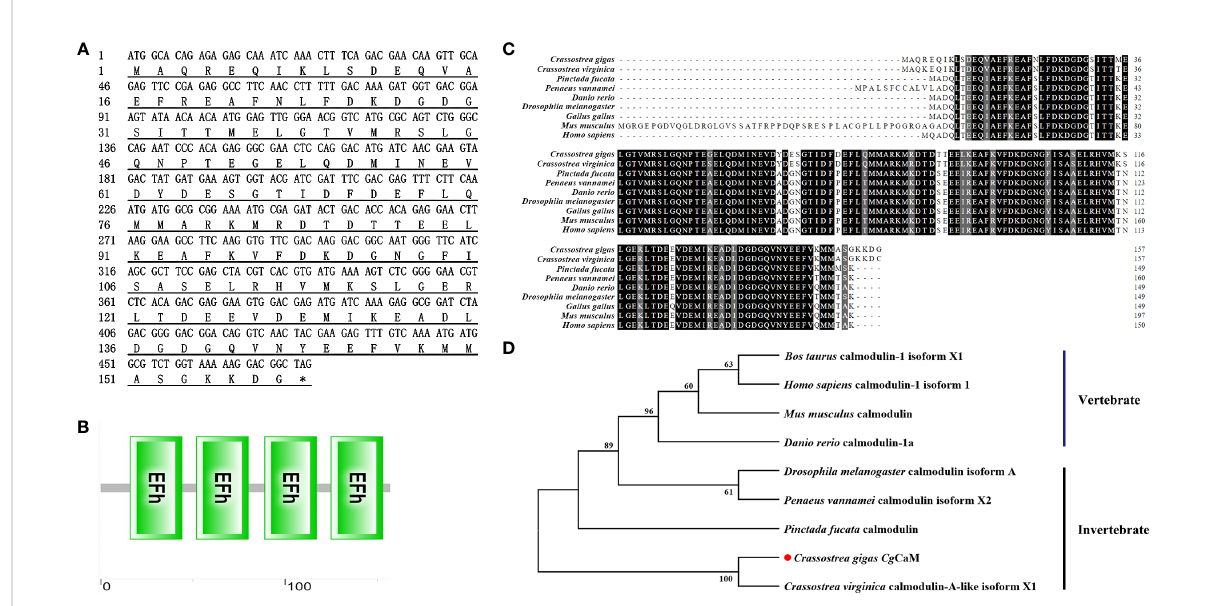
FIGURE 1 Bioinformatics analysis of Cg CaM. (A) Nucleotide and deduced amino acid sequence of Cg CaM. (B) Protein domains of Cg CaM predicted by SMART analysis. (C) Multiple sequence alignment of Cg CaM with known calmodulins from other species, including Crassostrea virginica (XP_022332301.1), Pinctada fucata (AAQ20043.1), Penaeus vannamei (ROT84624.1), Danio rerio (NP_892012.1), Drosophila melanogaster (NP_523710.1), Gallus gallus (NP_990336.1), Mus musculus (NP_001300863.1), Homo sapiens (NP_001350599.1). (D) Phylogenetic relationship of Cg CaM. Calmodulin sequences from different species were obtained from GenBank on NCBI, including Bos taurus calmodulin-1 isoform X1 (XP_024853610.1), Homo sapiens calmodulin-1 isoform 1 (NP_001350599.1), Mus musculus calmodulin (AAA66182.1), Danio rerio calmodulin- 1a (NP_998516.1), Drosophila melanogaster calmodulin isoform A (NP_523710.1), Penaeus vannamei calmodulin isoform X2 (XP_027237663.1), Pinctada fucata calmodulin (AAQ20043.1), Crassostrea gigas CaM (XP_011427026.1), Crassostrea virginica calmodulin-A-like isoform X1